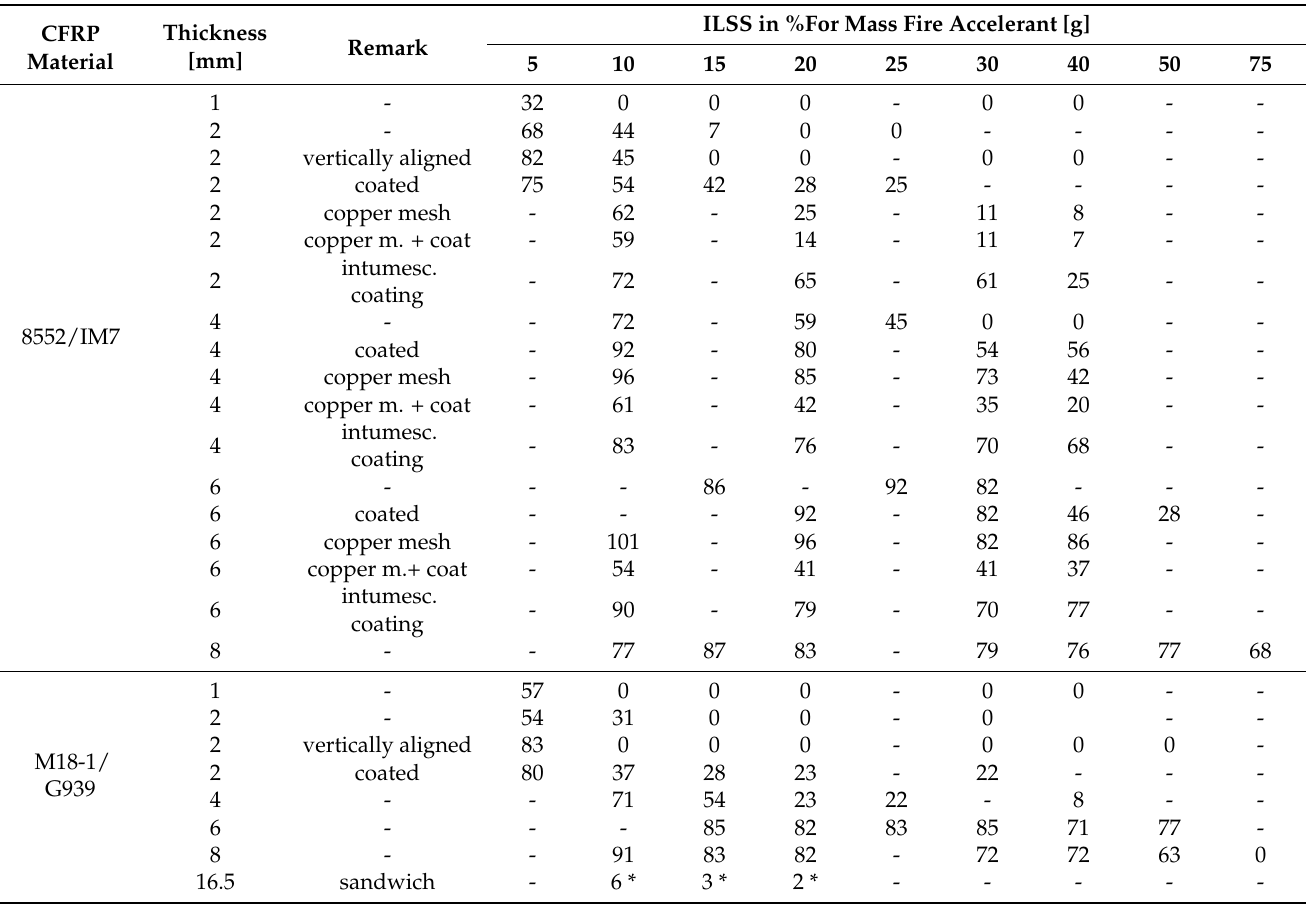
Table 2. Summary of all investigated samples and experimental conditions for laboratory tests. For each condition, the minimum residual interlaminar shear strength is given (ILSS is related to the initial values: 71 N/mm 2 for 8552/IM7 and 65 N/mm 2 for M18-1/G939; standard deviation is ~10% of the given